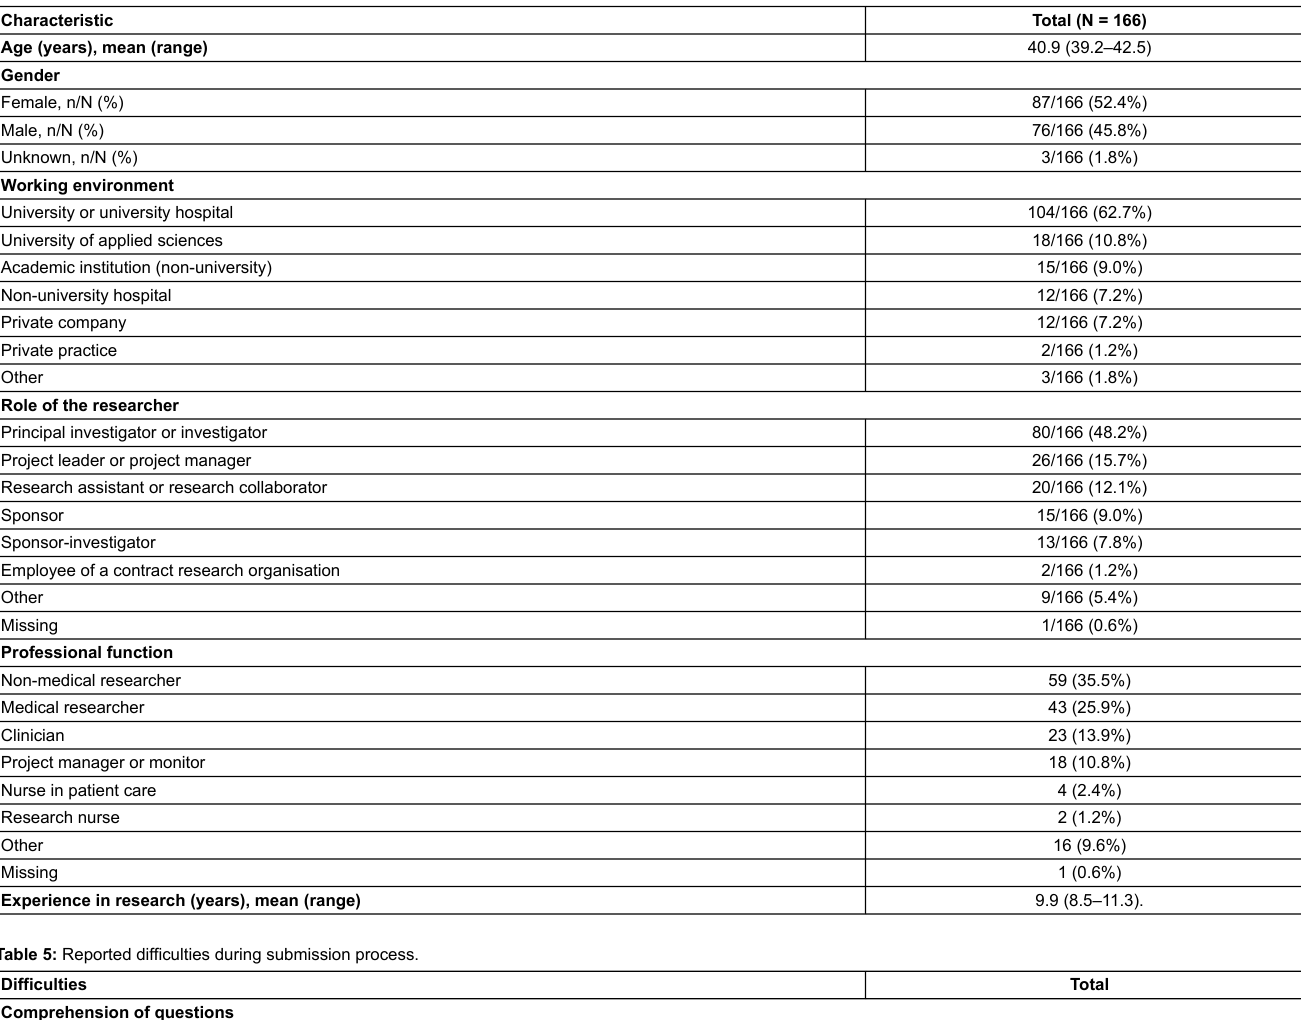
Table 4: Characteristics of survey respondents.